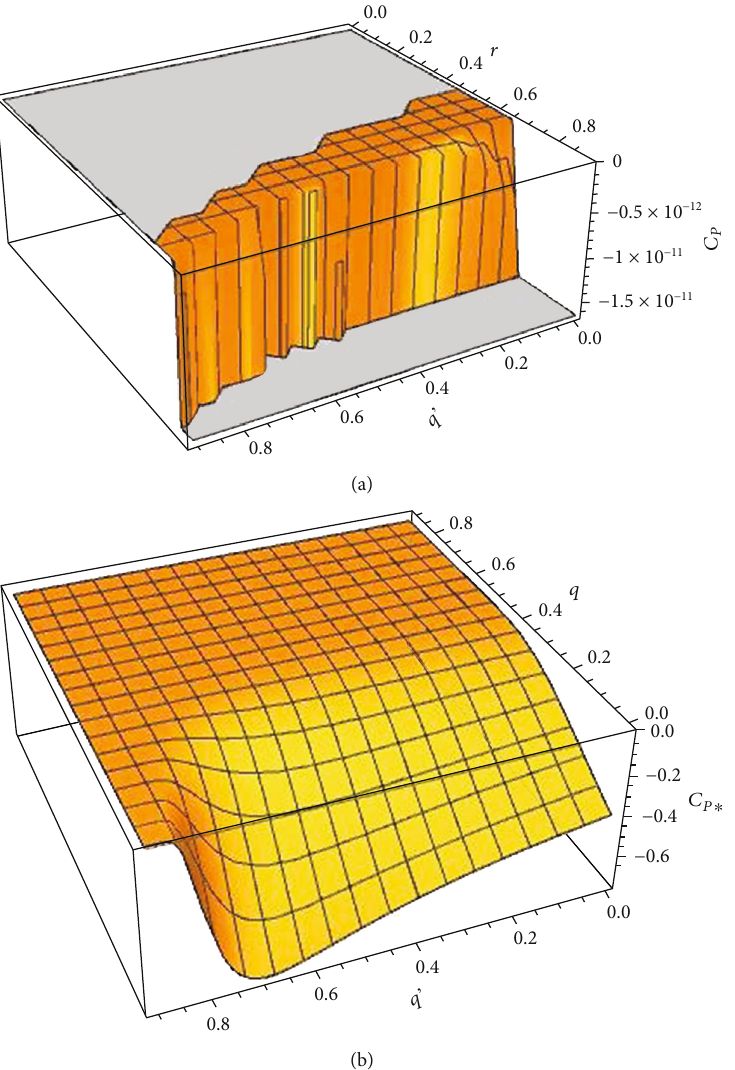
when q , q ′ vary and r = 0 : 8 , T = 3 , P ∗